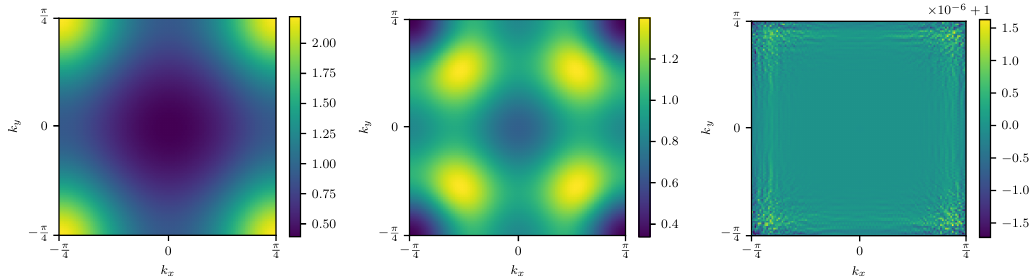
Figure 3: Berry curvature of the 4-band ( φ = 1 / 4 ) Hofstadter model (left), after one iteration of the flattening algorithm (middle), and after 19 iterations (right).